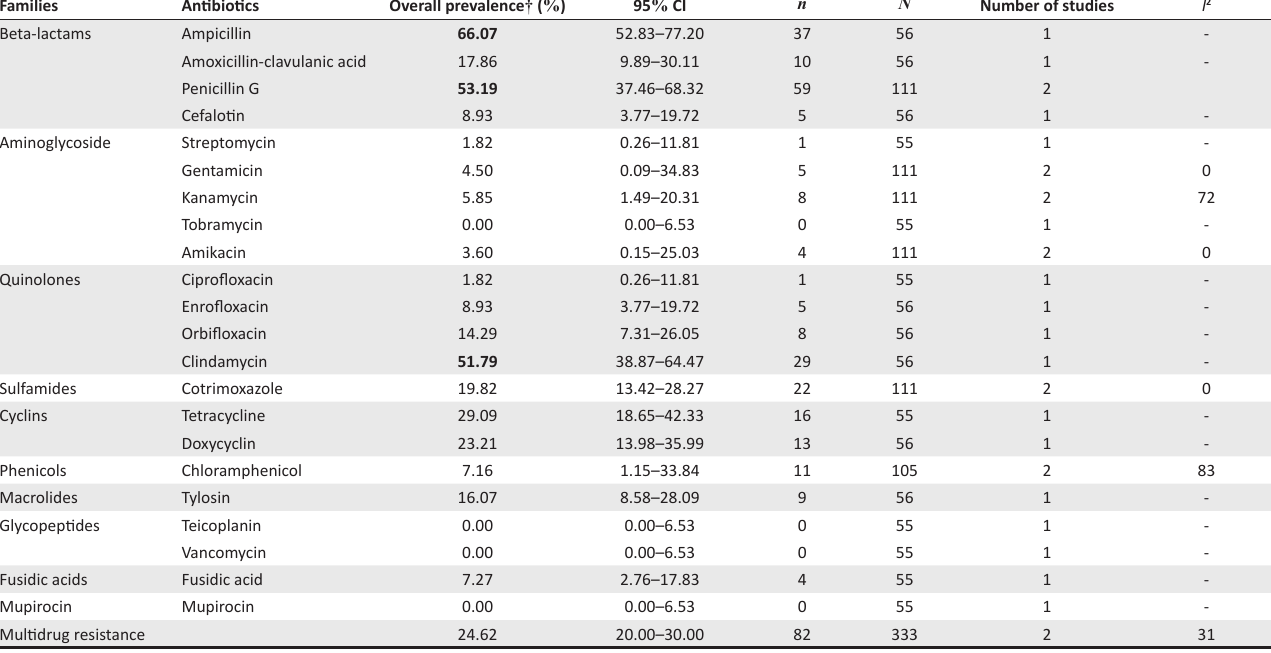
TABLE 8: The overall prevalence of antibiotic resistant Staphylococcus pseudintermedius strains isolated from dogs in Africa.